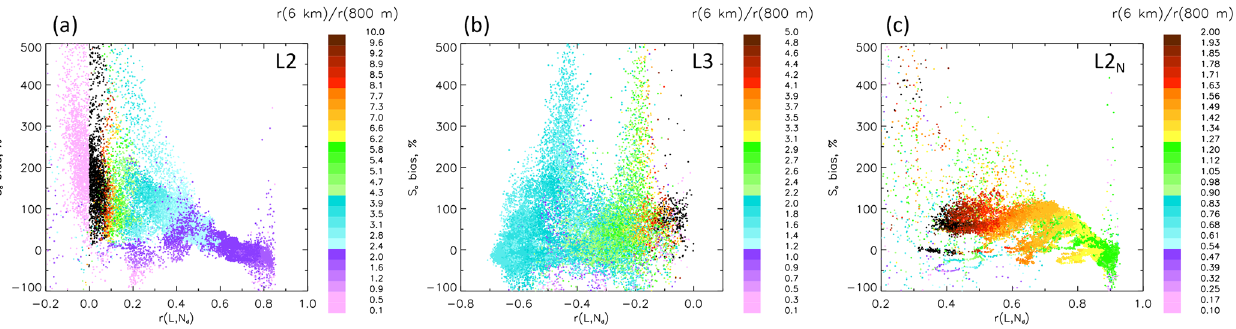
Figure 6. As in Fig. 4 but with points colored by the ratio of correlations r ( L , N d ) at 6km to r ( L , N d ) at 800m (the r ratio). Comparison with Fig. 5 shows approximately orthogonal dependence of the σ and r ratios on the S o bias. In (a) and (b) , calculation of the r ratio is mathematically unstable at r ( L , N d ) = 0, as evidenced by saturating